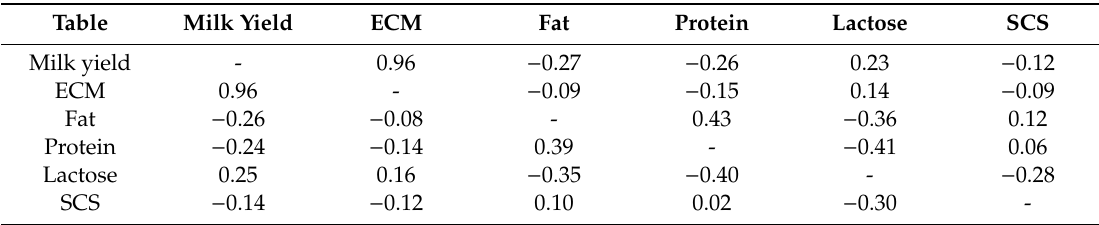
Table 2. Pearson’ correlations ( p < 0.001) among milk yield (kg / d), energy corrected milk (ECM, kg / d), composition traits (%), and somatic cell score (SCS, units) in primiparous (above diagonal) and multiparous bu ff aloes (below